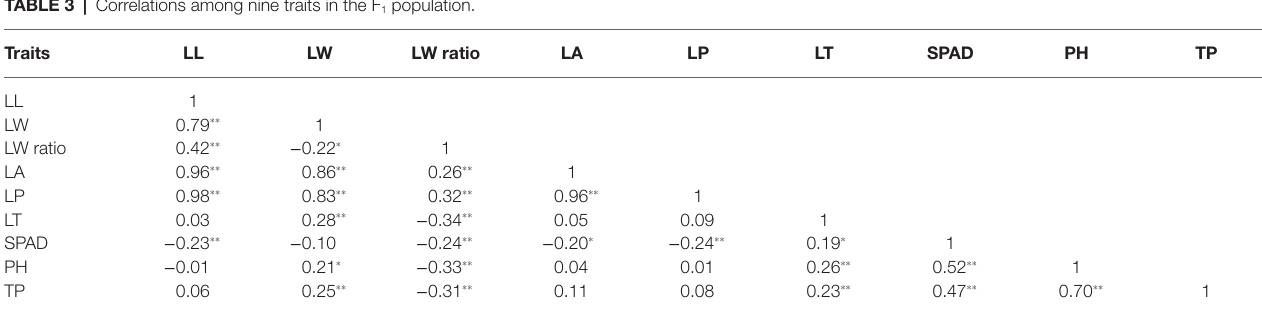
TABLE 3 | Correlations among nine traits in the F 1 population. Traits